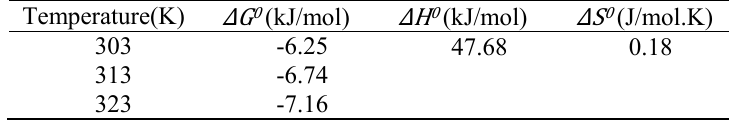
Table 4. Thermodynamic parameters for the adsorption of cobalt on magnetite-citric acid